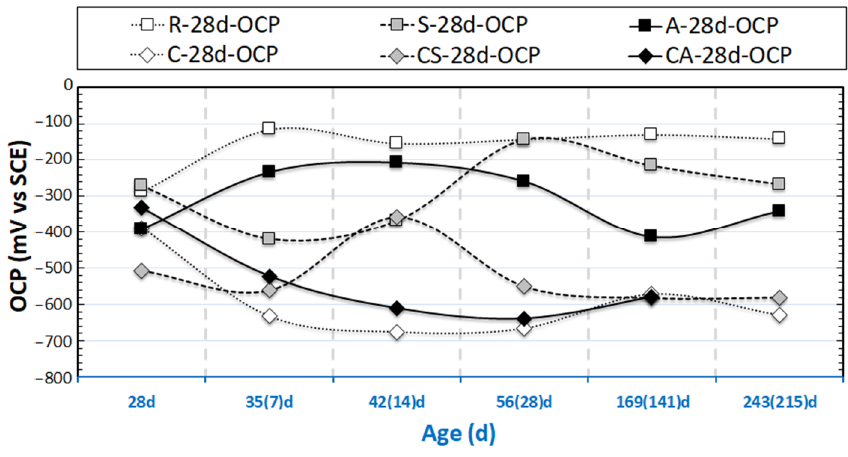
Figure 5. OCP evolution of 28d-cured samples (R-28d: Reference; S-28d: Stray Current; A-28d: Anodic Polarization; C-28d: NaCl medium; CS-28d: NaCl + Stray Current; CA-28d: NaCl + Anodic Polarization); The numbers in brackets denote the conditioning duration.